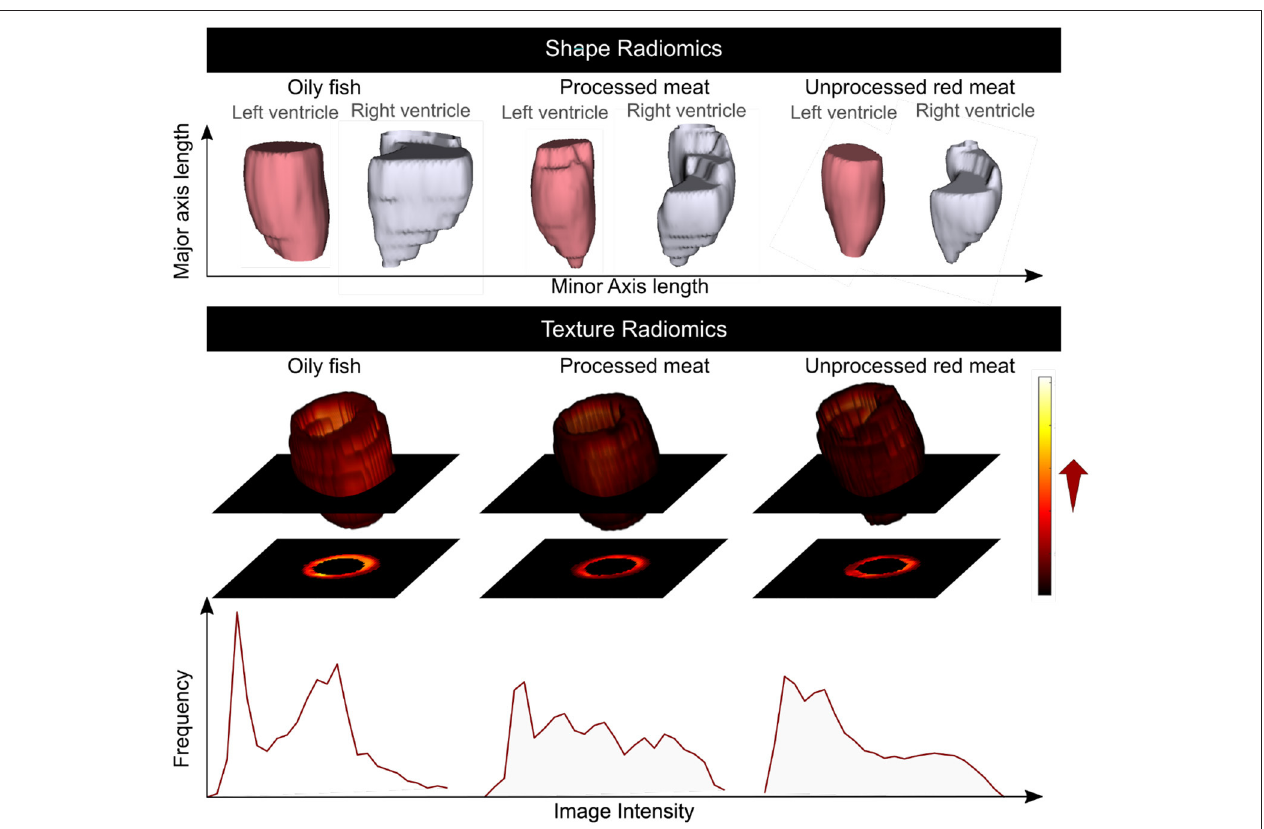
FIGURE 6 | Summary of the association of the oily fish, processed meat, and unprocessed red meat intake with the CMR radiomics shape and signal intensity-based features. Greater red and processed meat intake was associated with smaller ventricular volumes, reduced short axis dimension, and a more elongated shape; lower global signal intensity levels, and less variation in SI levels within the LV myocardium. Greater oily fish consumption was associated with larger ventricles with overall less elongated (more spherical) shape, higher global myocardial intensity levels and more variation of myocardial intensities. CMR: cardiovascular magnetic resonance. Histograms are from a selection of most illustrative cases and do not represent findings from the whole dataset.